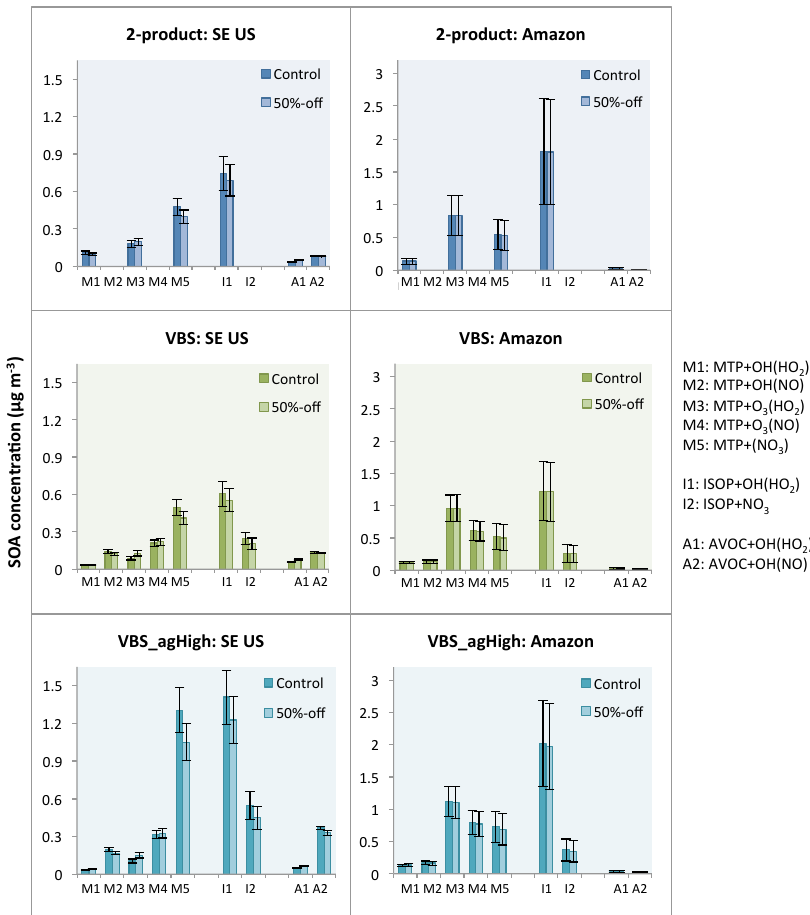
Figure 10. Annual mean surface SOA concentration (µgm − 3 ) in the control runs and the sensitivity runs (with 50% anthropogenic NO emission off) from different pathways, averaged over the southeast US (32–40 ◦ N, 95–77 ◦ W) and the Amazon (17 ◦ S–5 ◦ N, 77–55 ◦